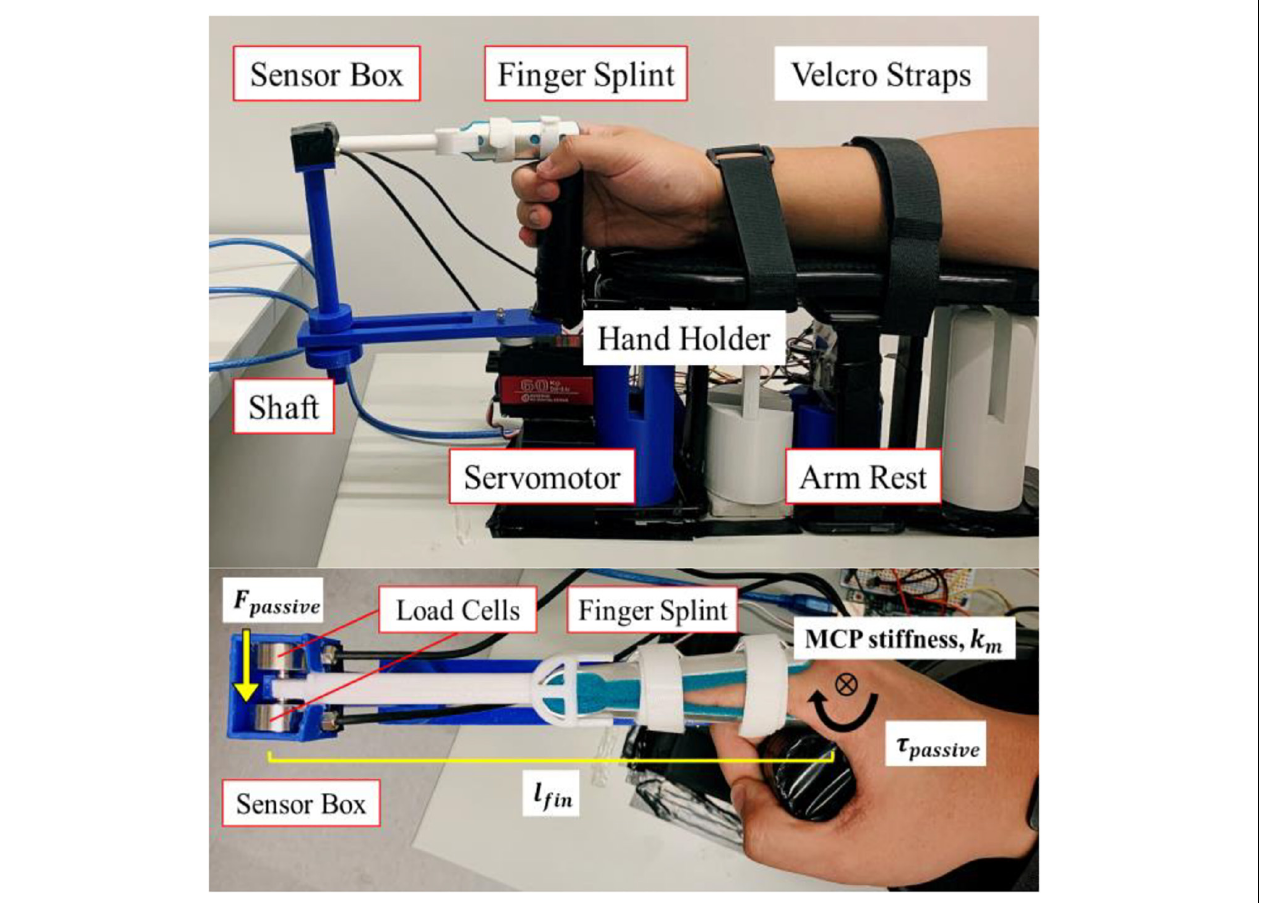
FIGURE 3 | Stiffness measurement device replicated from Esteki and Mansour (1996) and Kuo and Deshpande (2012) for MCP joint stiffness testing in index finger. Two load cells are placed in the sensor box. The finger splint is embedded in the sensor box. The MCP joint is rotated by the DC servomotor. The forearm is secured on the arm rest, which includes Velcro straps and a hand